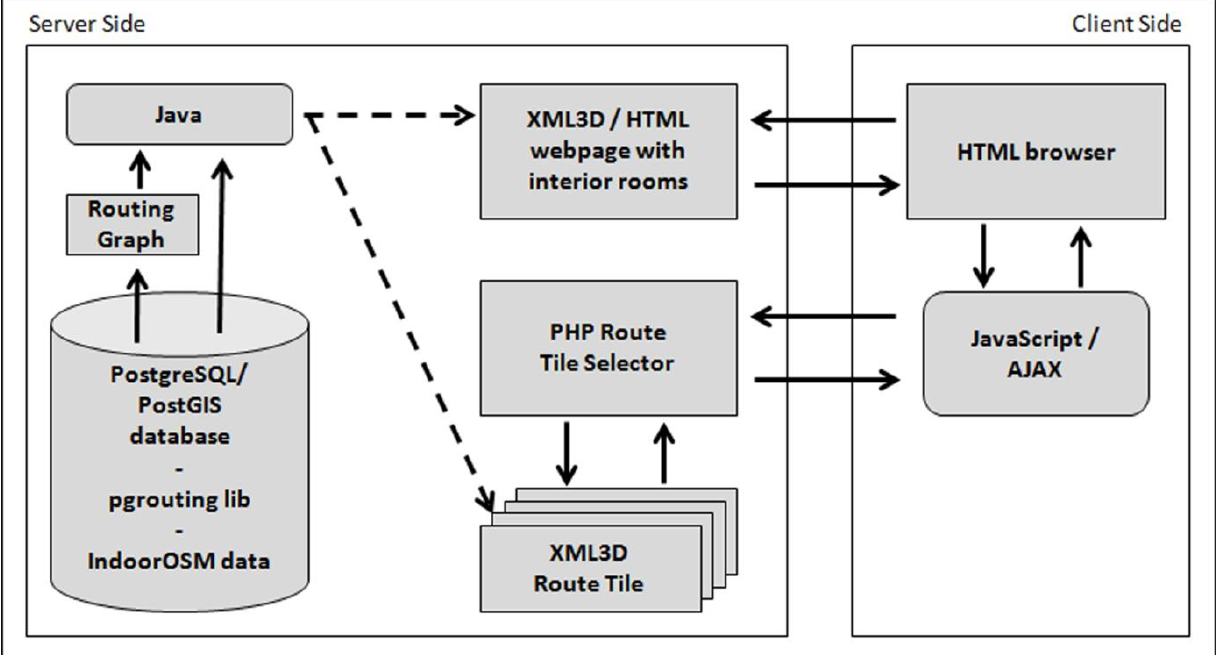
Figure 2. System architecture and processing workflow of the 3D indoor routing